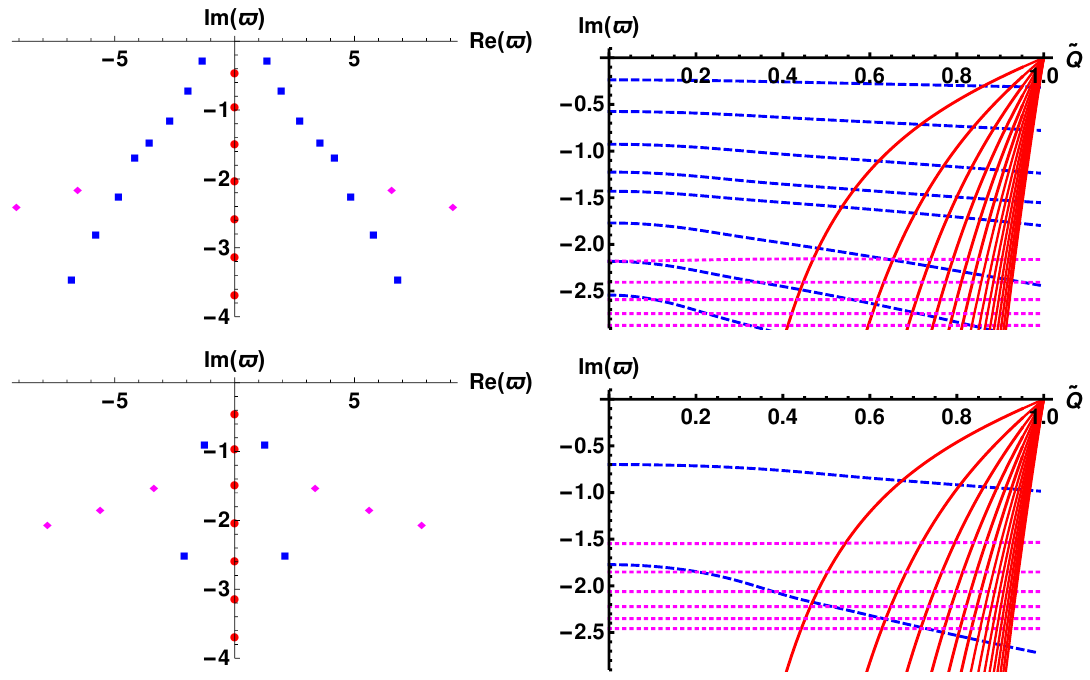
Figure 5 . Left column: the QNMs of the glued background at e Q = 0 . 8 and X = − 0 . 47 . Right column: the charge dependence of the imaginary parts of the QNMs at X = − 0 . 47 . Top row: intermediate temperature, T = 1 . 4 . Bottom row: high temperature, T = 1 . 2 . The red c /T c /T filled circles/solid curves, blue boxes/dashed curves, and magenta diamonds/dotted curves are the imaginary near-horizon modes (set(iv)), the CR modes (set (ii)), and the AdS modes (set (iii)),